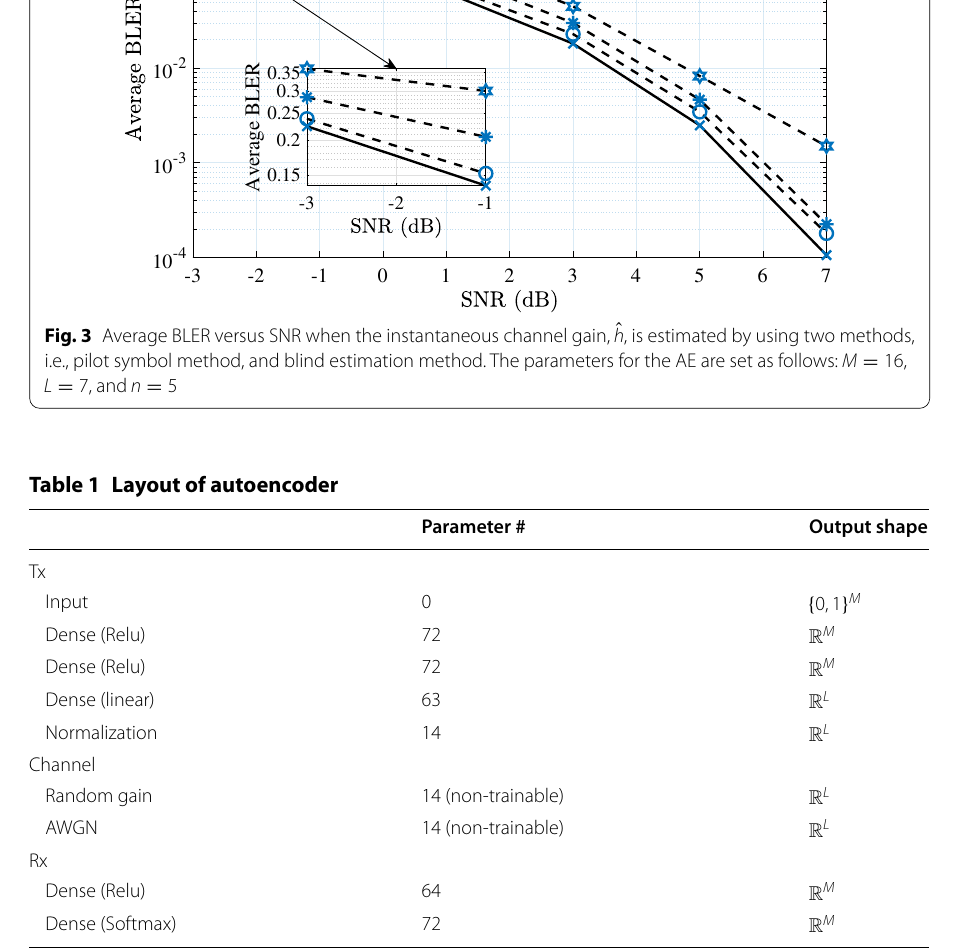
ˆ h , is estimated by using two methods,